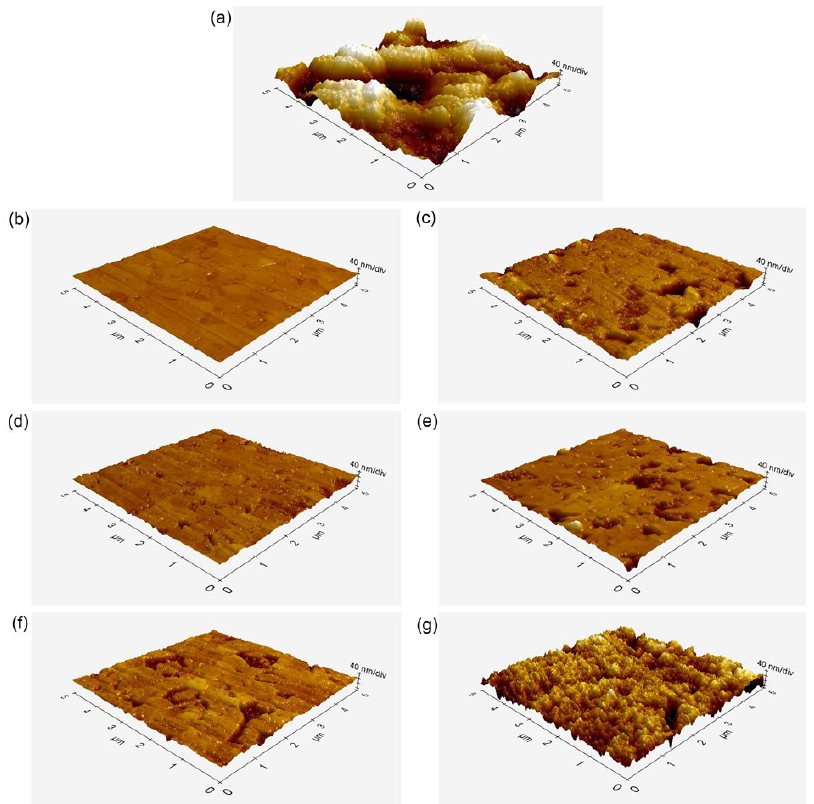
Figure 3. Atomic force microscopy (AFM) images of the zirconia ceramic specimens after different surface treatments (5 μm × 5 μm): ( a ) APA; ( b ) 10F5; ( c ) 10F30; ( d ) 20F5; ( e ) 20F30; ( f ) 30F5; ( g ) 30F30. Note that more retentive surface morphologies were produced with increasing concentration and application time of the etching